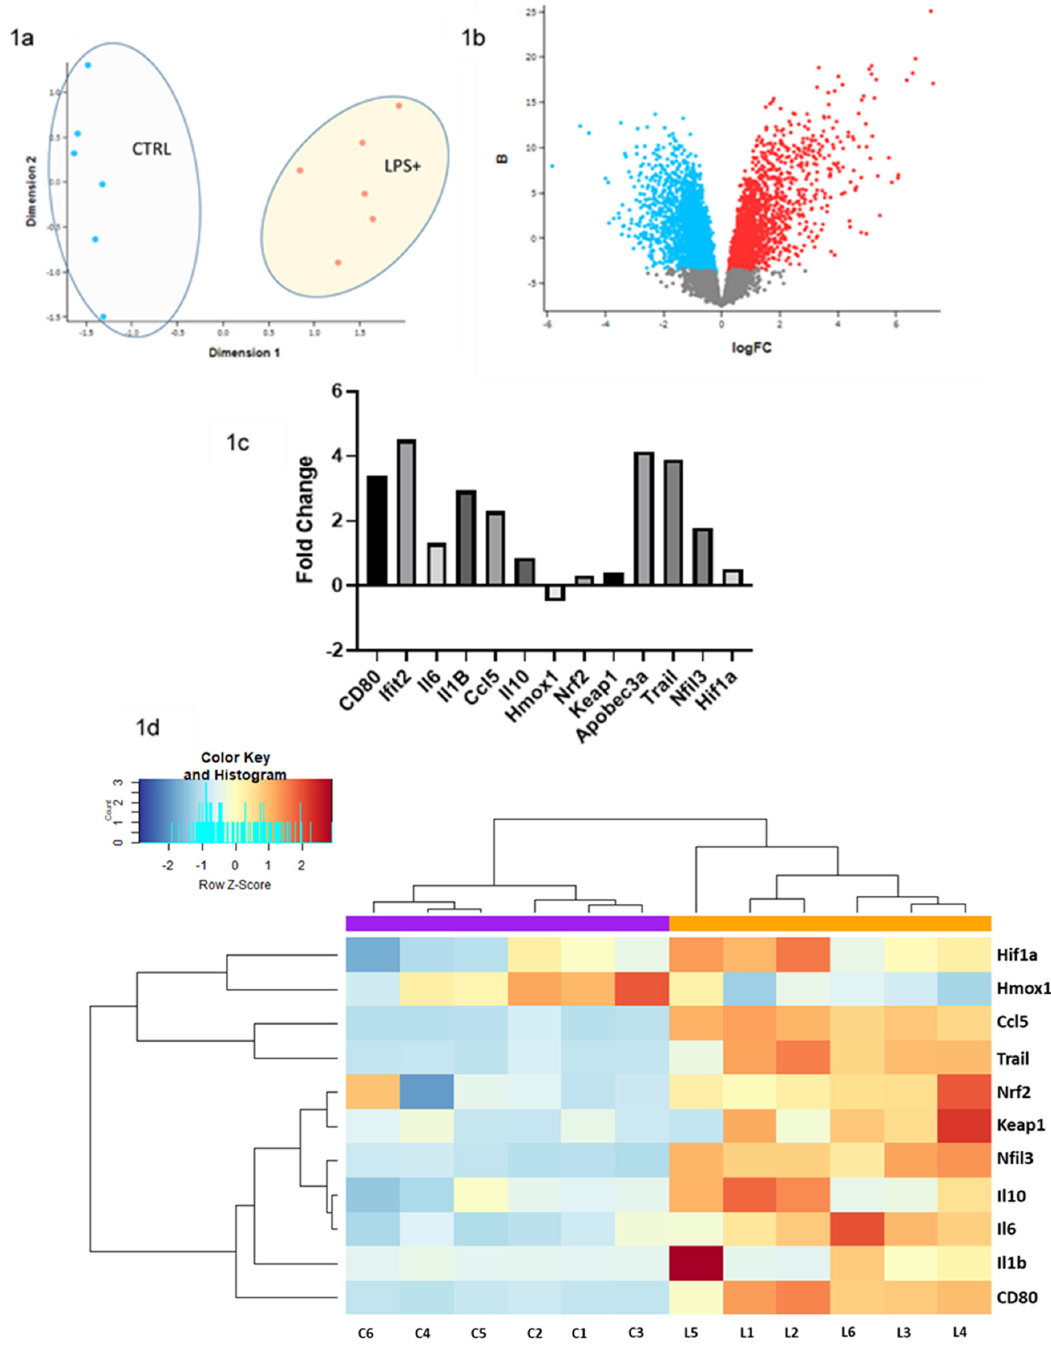
Figure 1. Cont Figure 1. Cont.